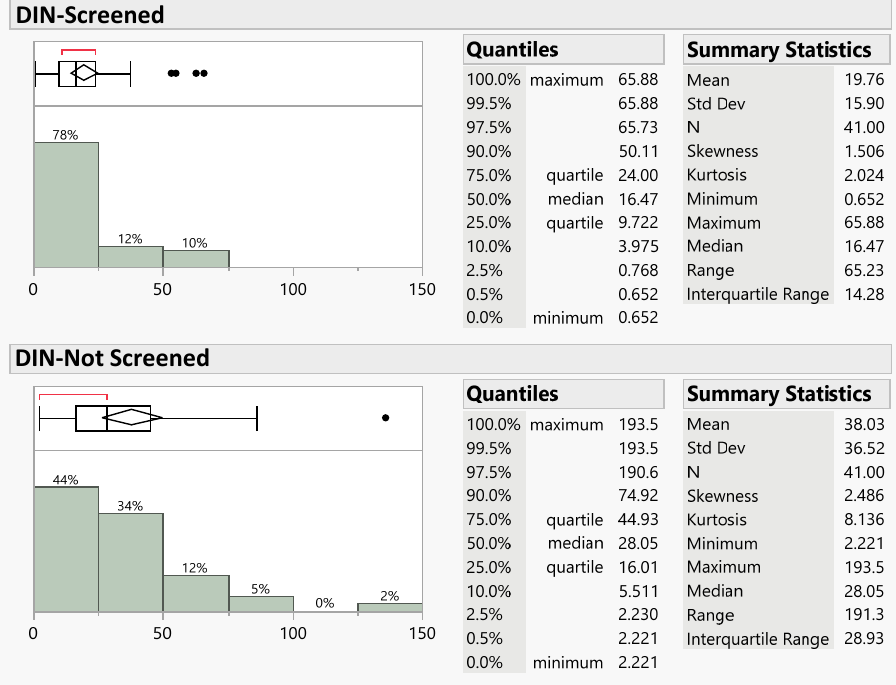
Figure 12. Distributions and summary statistics for the screened and unscreened DIN samples collected side by side. The x -axis does not include the full range of the data to better show detail in the lower range. Data units are mg/m 2 /week.